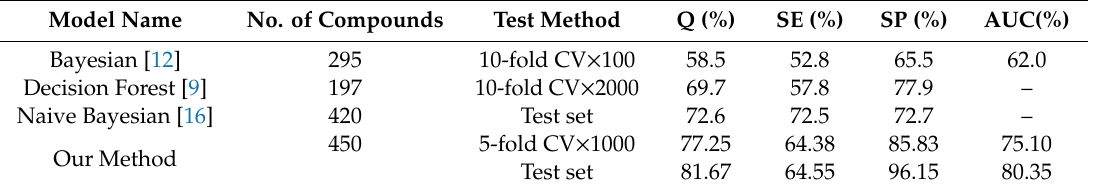
Table 4. Performance Comparison of Several Hepatotoxicity Prediction